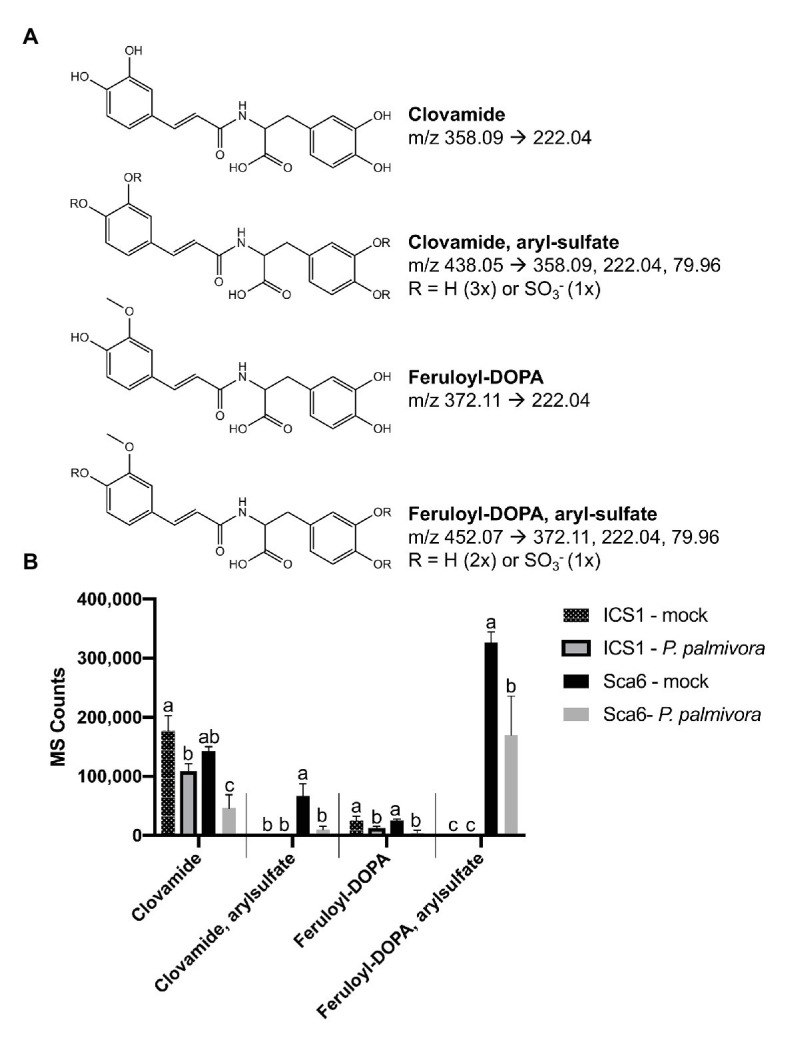
Changes in four HCAAs during fruit/pod infection by P. palmivora. (A) Putative structures of two sulfated HCAAs, feruloyl-DOPA, and clovamide. Parent ion m/z ([M-H]−) and diagnostic MS/MS fragments shown. (B) Metabolite abundance of the same four HCAAs in ‘ICS1’ and ‘Sca6’ fruit/pod tissue, mock inoculated or infected by P. palmivora. MS Counts represent mass spectrometer signal intensity of peaks integrated in XCMS Online (Tautenhahn et al., 2012). Shared letters mean no difference by Tukey-HSD (p < 0.05, n = 3). Error bars represent standard deviation.